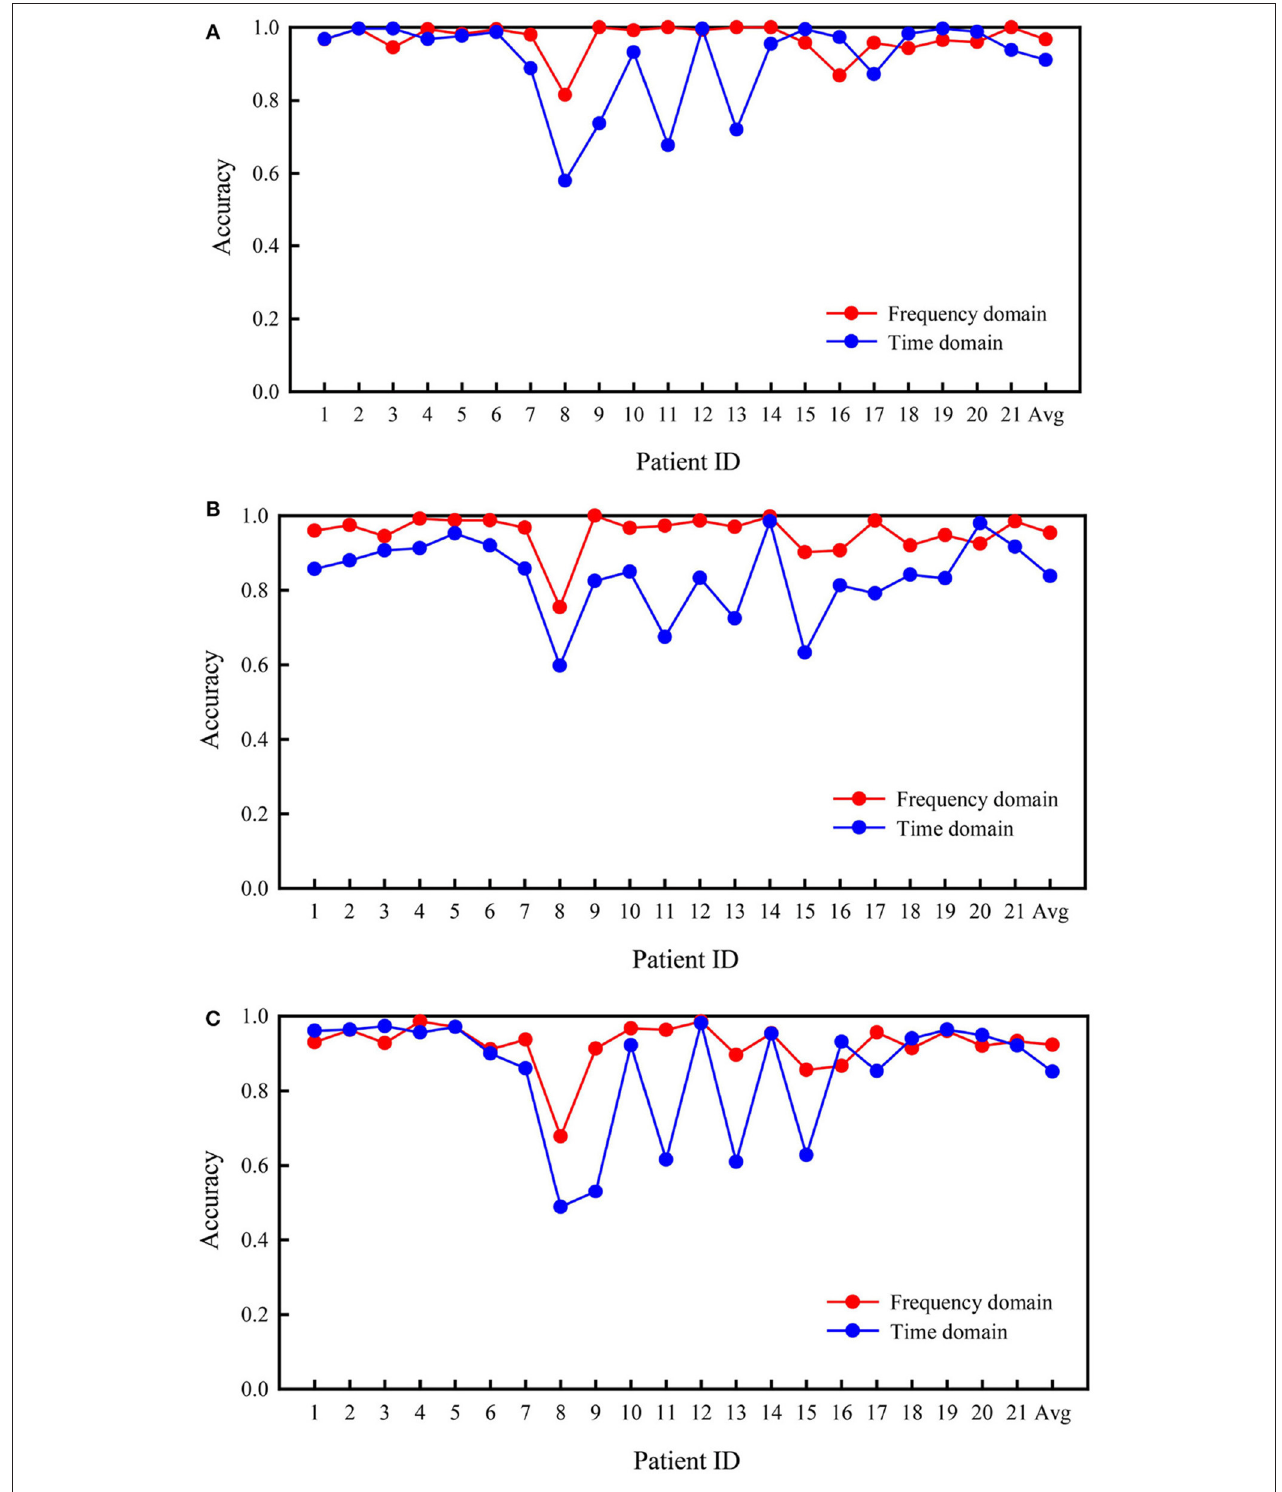
FIGURE 4 | Comparison of accuracies in the Freiburg database based on frequency and time domain signals. (A) Interictal vs. preictal. (B) Interictal vs. ictal. (C) Interictal vs. ictal vs. preictal.